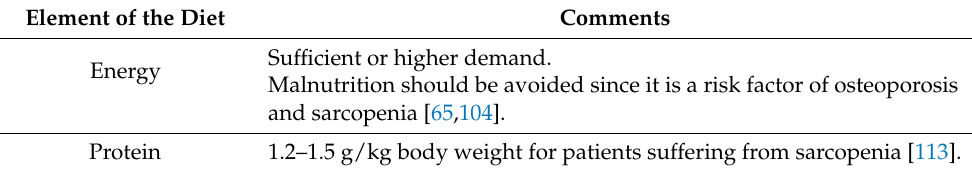
Table 4. Calorie, protein, fat, and vitamin intake and the risk of osteosarcopenia in patients suffering from IBD. Element of the Diet Comments Sufficient or higher demand. Energy Malnutrition should be avoided since it is a risk factor of osteoporosis and sarcopenia